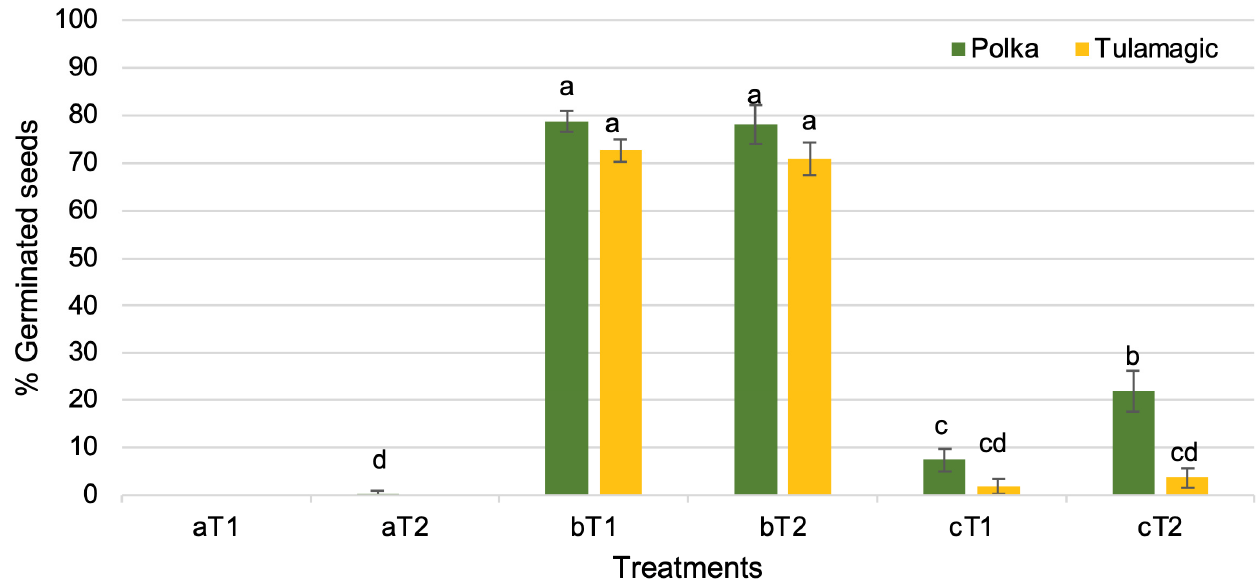
Figure 4. Data on in vitro germination frequency of seeds from “Polka” and “Tulamagic” open pollination exposed to different types of mechanical and temperature treatments: uncut seed (aT1), transverse cutting (bT1), and seed with longitudinal incision (cT1) stored at 4 °C for 14 days and then placed in a growth chamber at 24 °C; uncut seed (aT2), transverse cutting (bT2), and seed with longitudinal incision (cT2) placed directly at 24 °C. Results are expressed as the (number of germinated seeds/total treated seeds) × 100 at 60 days after treatment. One-way ANOVA was used to analyze the data. Different letters show significant differences at p < 0.05 by Duncan’s test (n = 125). Each value represents the mean ± standard deviation of three independent experiments.